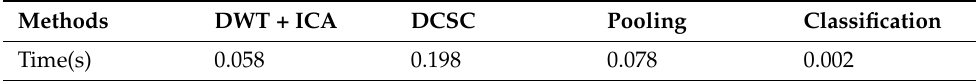
Table 4. Computation time for each stage for a test